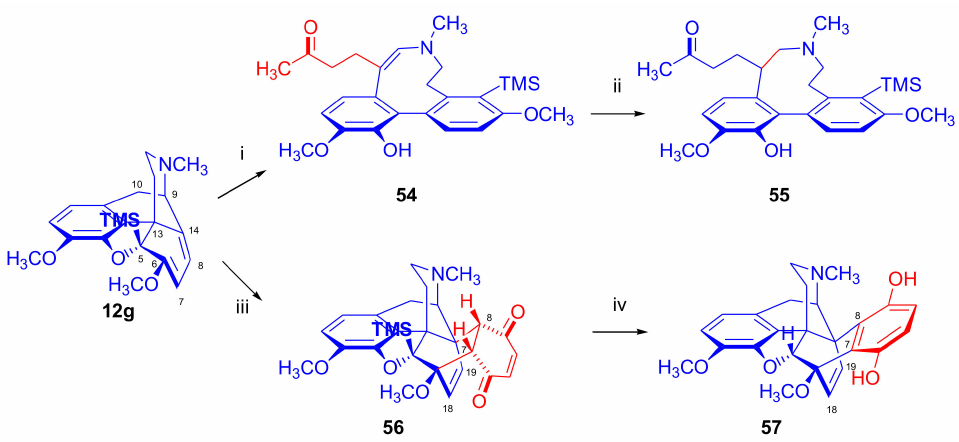
Figure 18. Reaction of 5 β -trimethylsilylthebaine with methyl vinyl ketone and p -benzoquinione. Reagents and conditions : (i): methyl vinyl ketone, toluene, reflux, (ii): H 2 , Pd-C, (iii): p -benzoquinone, 45 ◦ C, 7 days, and (iv): tetrabutylammonium